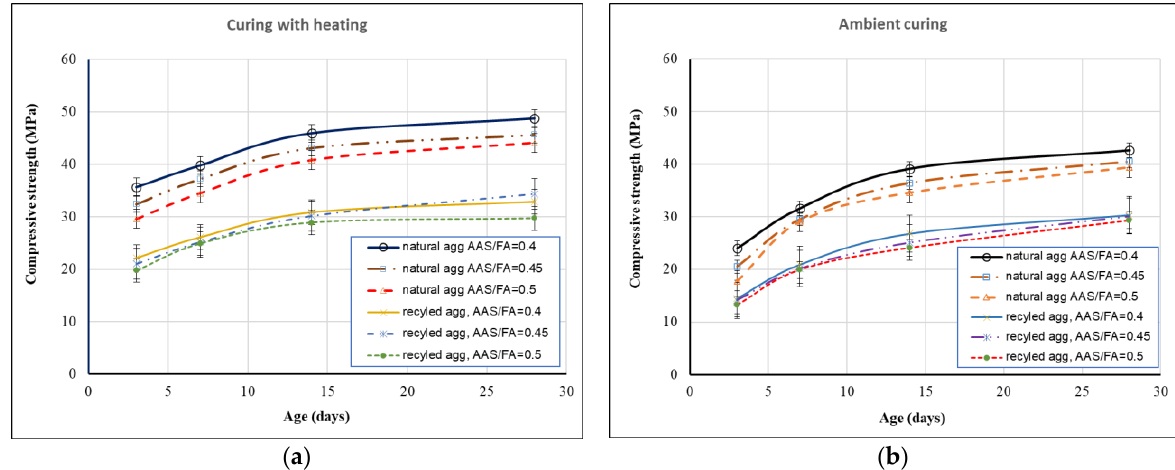
Figure 9. Compressive strength of GRAC and control mixture without superplasticizer; ( a ) cured at 60 ° C; ( b ) cured at ambient conditions.